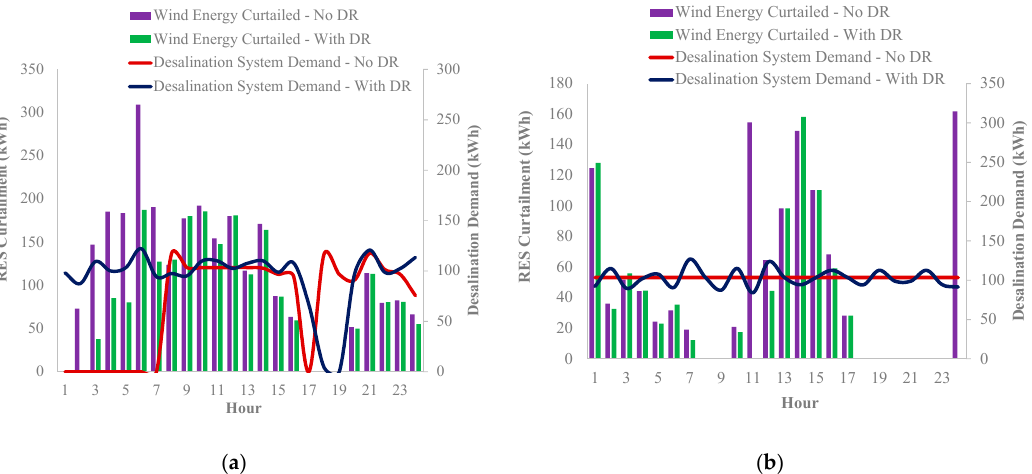
Figure 9. Comparison of the RES curtailment and the desalination system demand, when the desalination system satisfies the water requirements of the whole island of Kythnos. Operation with & without the relevant DR capabilities for ( a ) 06/01/2019 and ( b ) 13/07/2019.